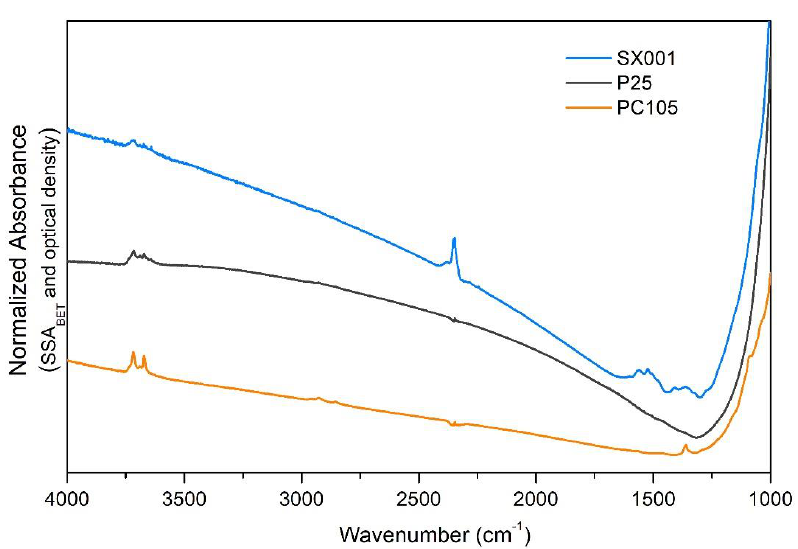
Figure 2. MIR spectra of SX001 (light blue), P25 (dark grey), PC105 (orange) after activation at 873 K. All the spectra have been normalized by dividing the absorbance by the specific surface area (m 2 / g) and the “optical thickness” (g / m 2 ) of the pelletized samples.